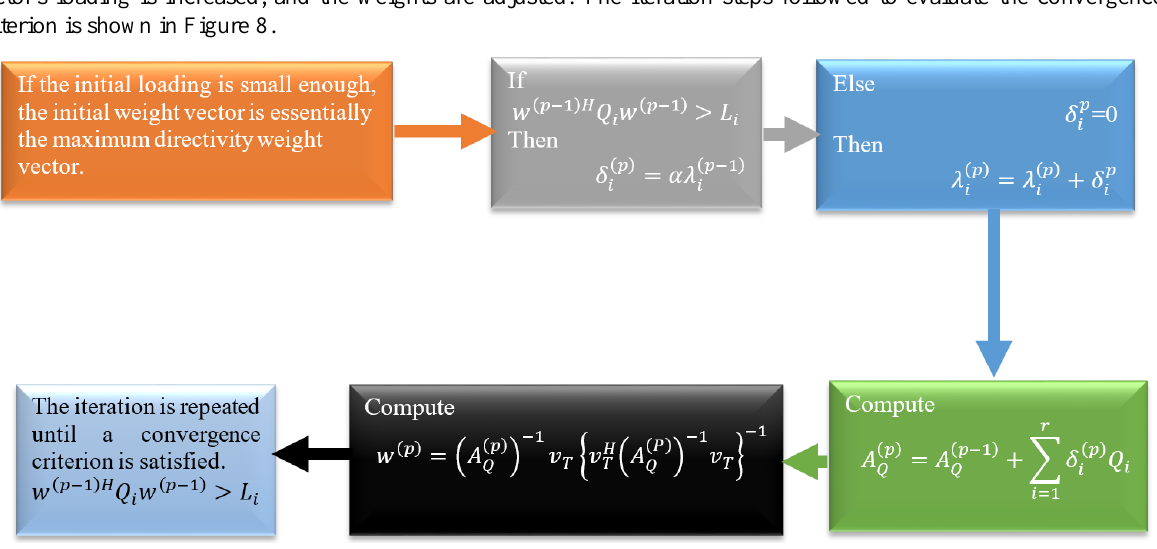
Figure 8. Steps to evaluate the repetitive iteration until conversion criterion